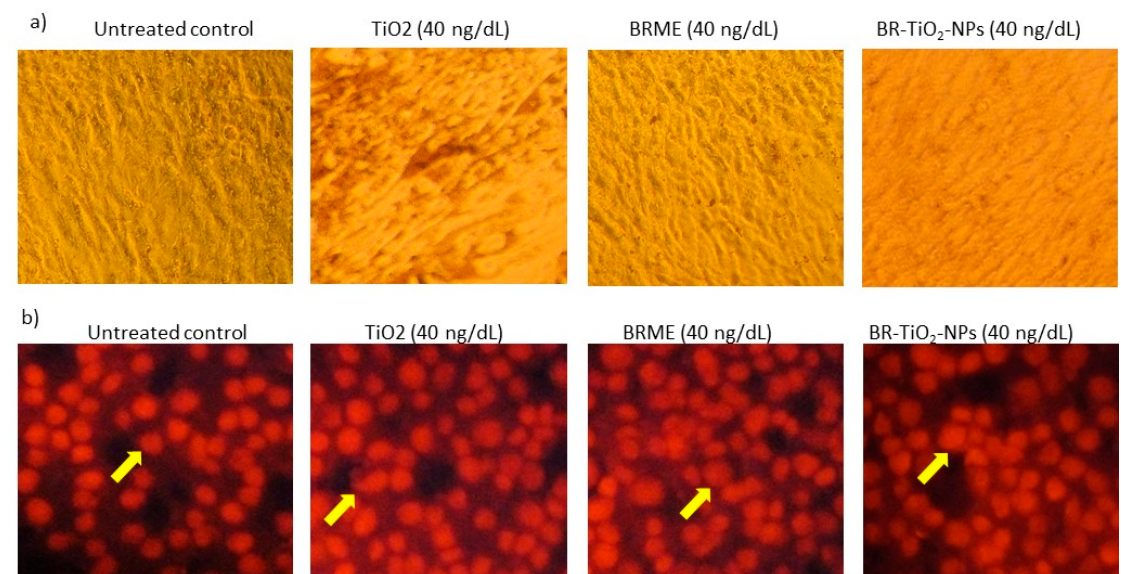
Figure 3. hMSCs cell morphology assay for the biosafety. ( a ) Light microscopy images and ( b ) Propidium iodide staining images of the control, and adipocytes treated with TiO 2 , BRME, and BR-TiO 2 -NPs for 48 h.